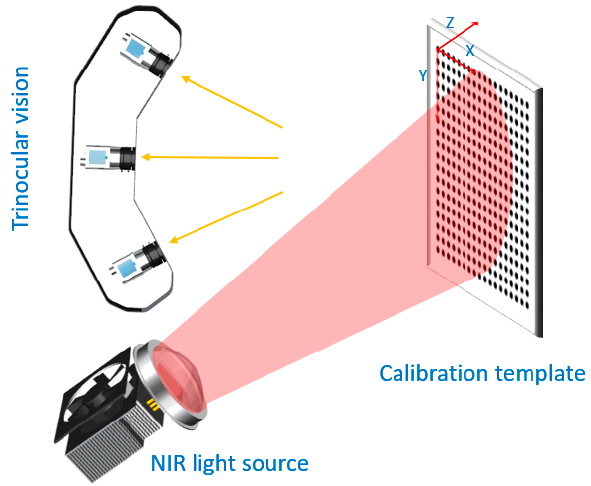
Figure 6. NIR trinocular stereo vision calibration.